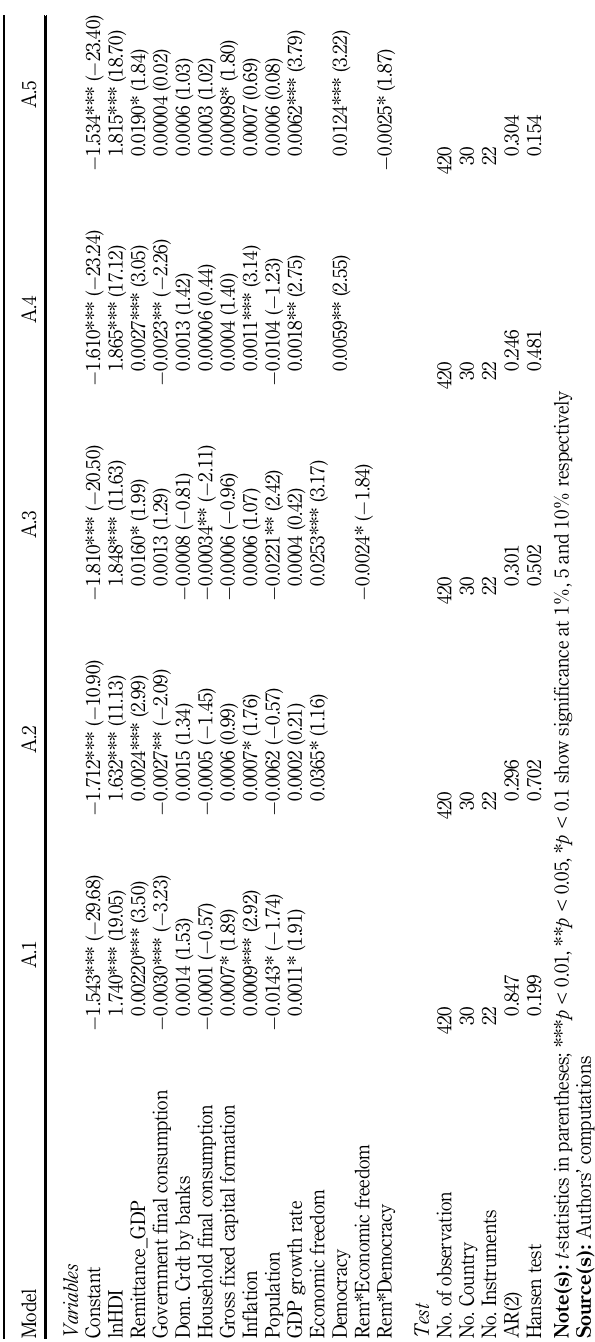
Table 4. Results on remittances, institutional quality and human